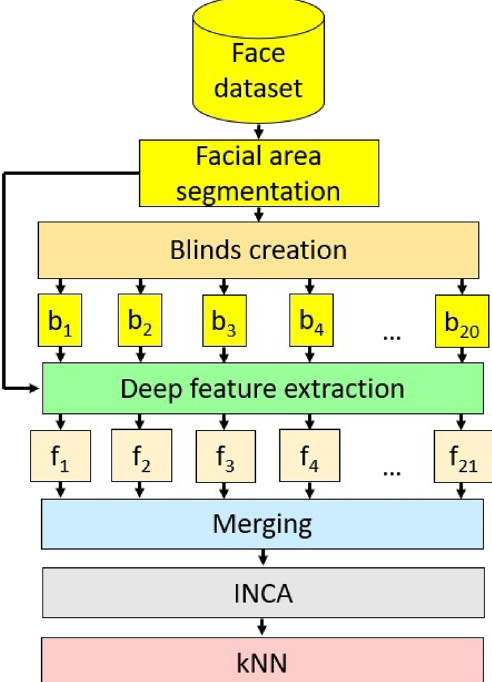
Figure 4. Schema of the proposed model based on shutter blinds-based deep feature